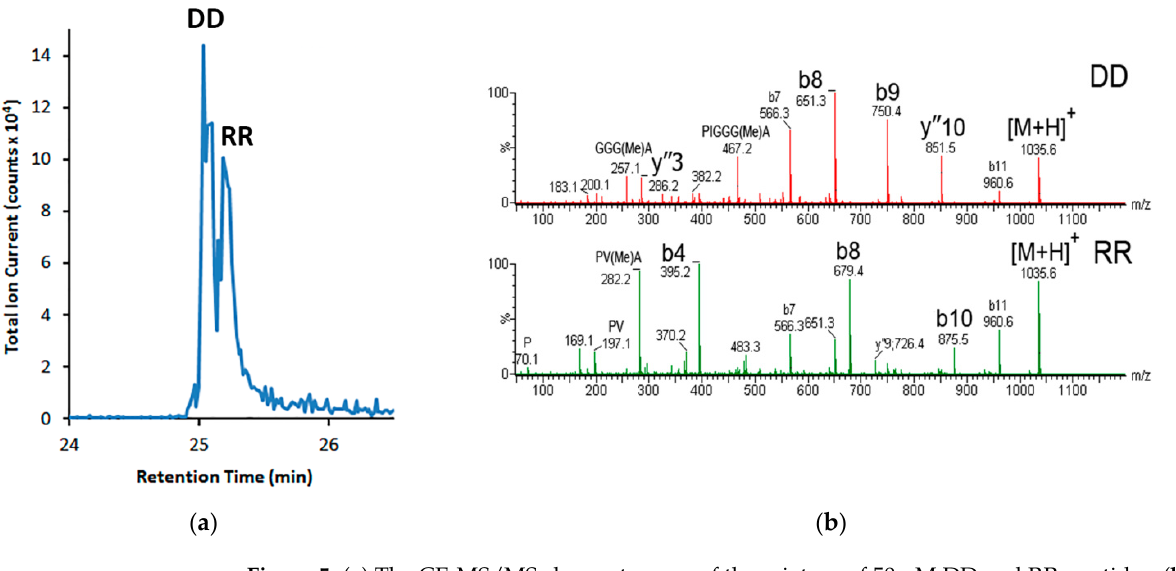
Figure 5. ( a ) The CE-MS/MS chromatogram of the mixture of 50 μ M DD and RR peptides; ( b ) the MS/MS scans of 25.03 min peak shows the characteristic ions of the DD peptide and 25.20 min peak shows the characteristic ions of the RR peptide.